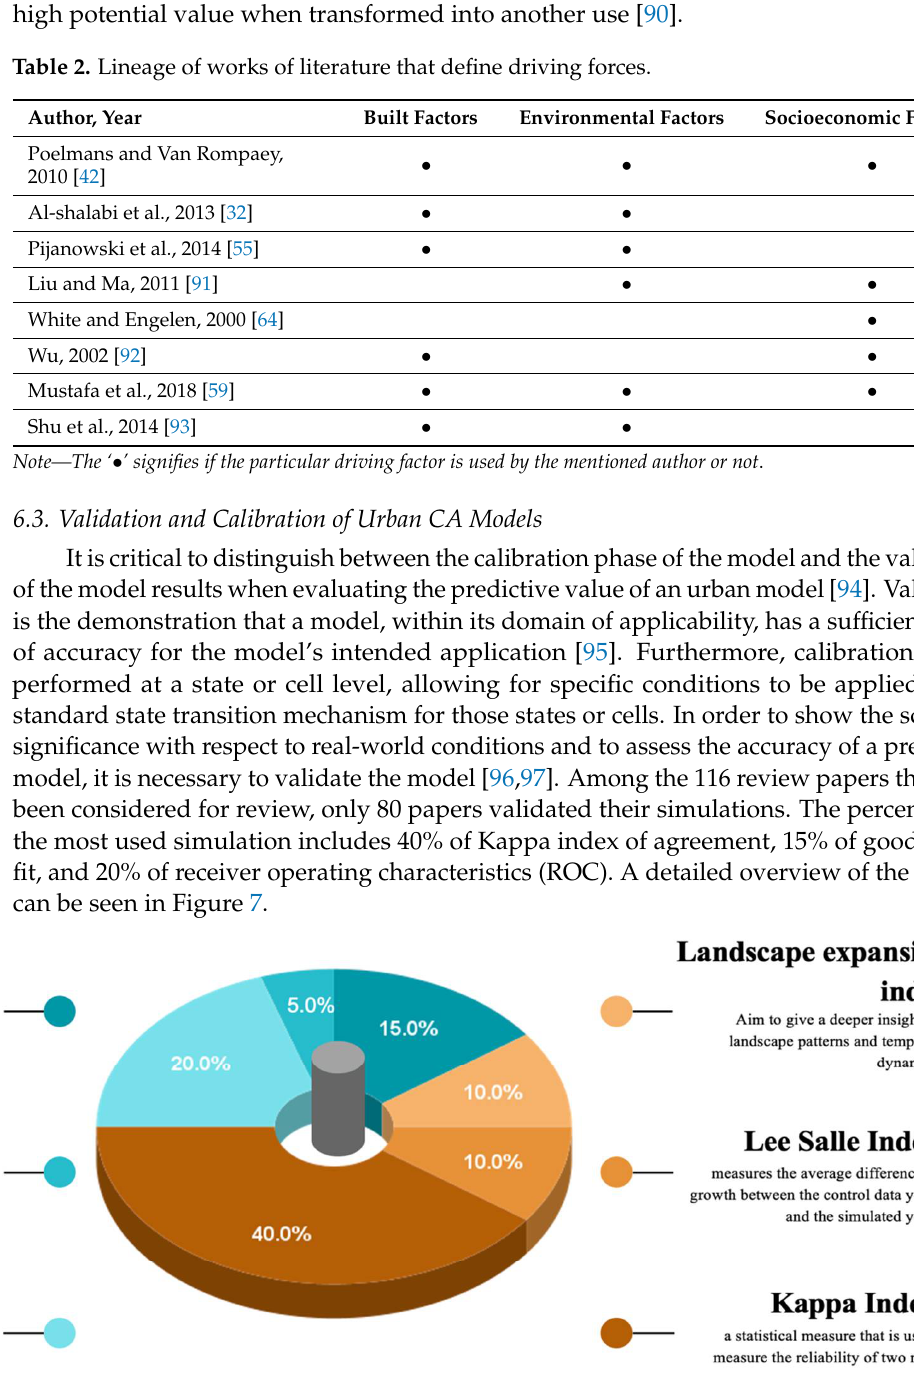
Figure 7. An overview of validation method adopted across considered